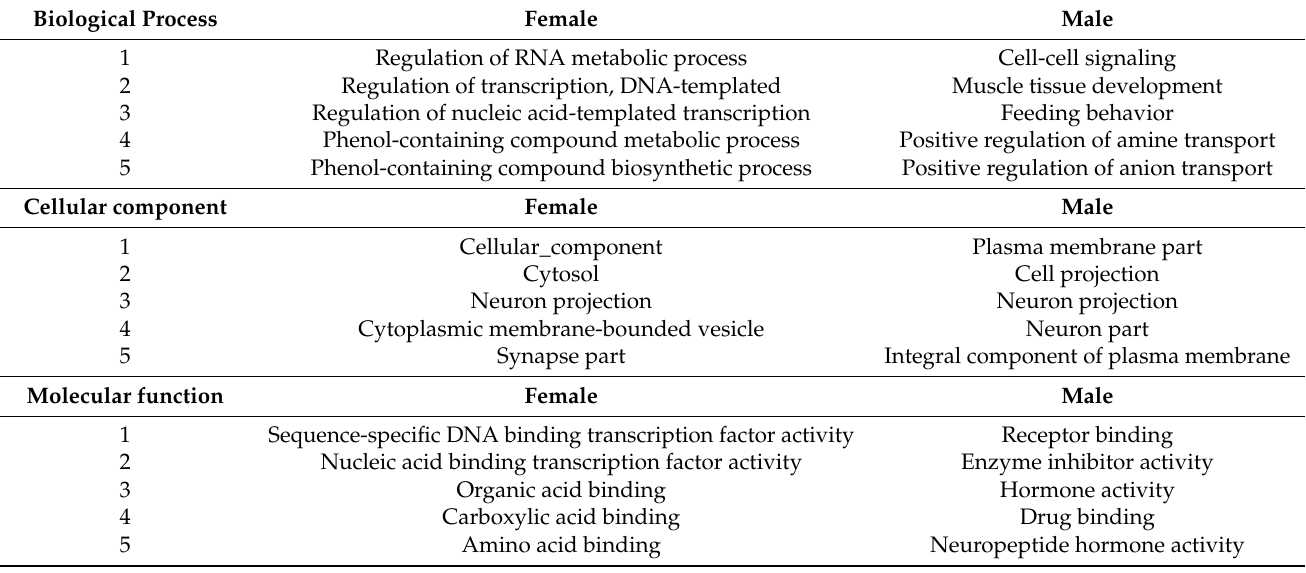
Table 3. Top 5 statistics of GO enrichment for DEGs in the brains of 2.5 × FA female and male mice.